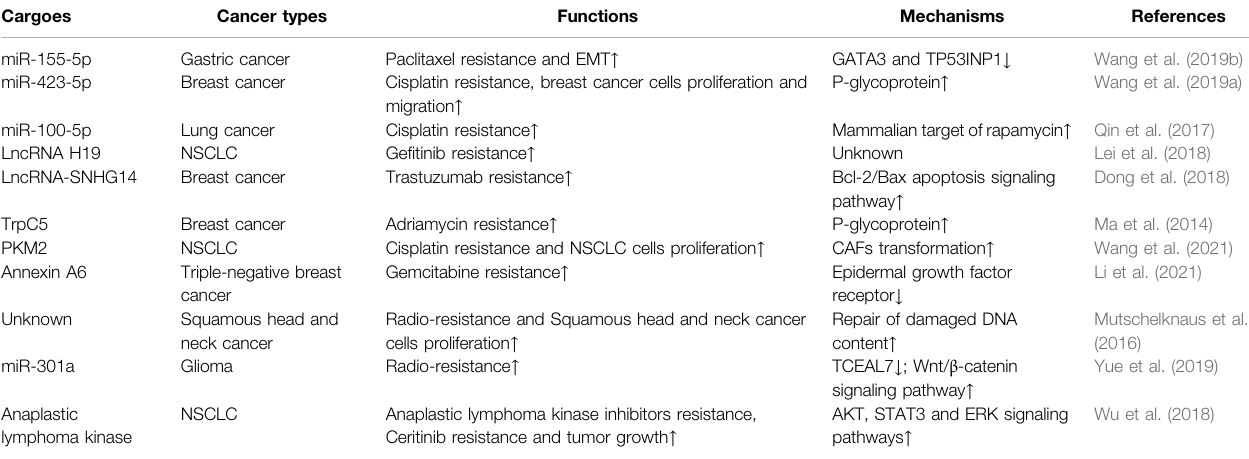
TABLE 2 | Role of tumor-derived EVs in therapy resistance.